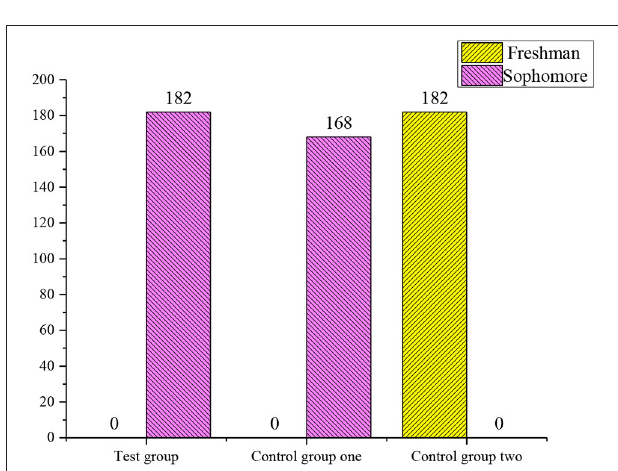
FIGURE 4 | The chi-squared test of the gender among the experimental group, control group 1, and control group 2. χ 2 = 0, p = 1.00 > 0.05. There is no significant difference in the gender among the groups.